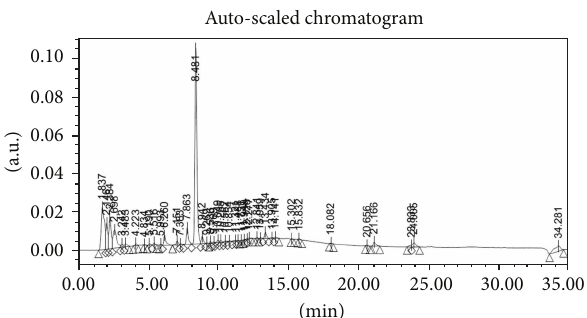
Figure 7: HPLC chromatogram of the ethanol extract of Scutellaria baicalensis .